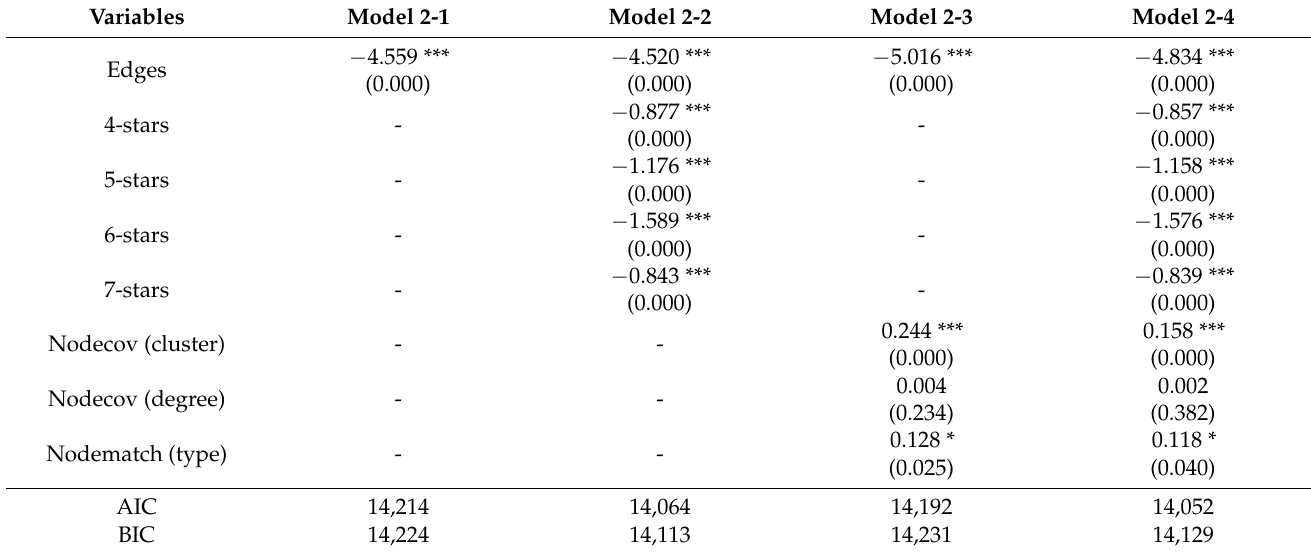
Table 7. Results of the interactive network (Net2).